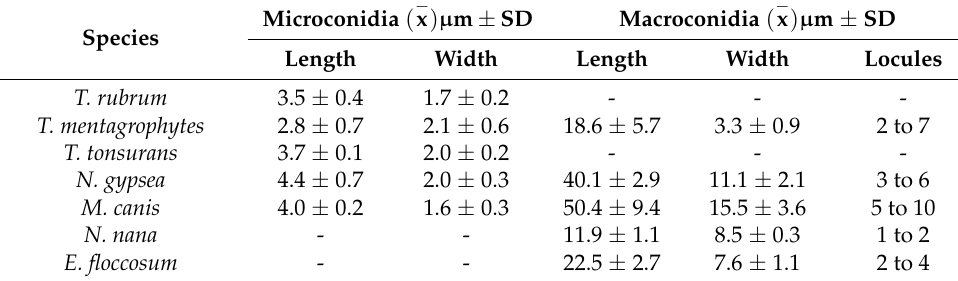
Table 2. Conidia size of identified